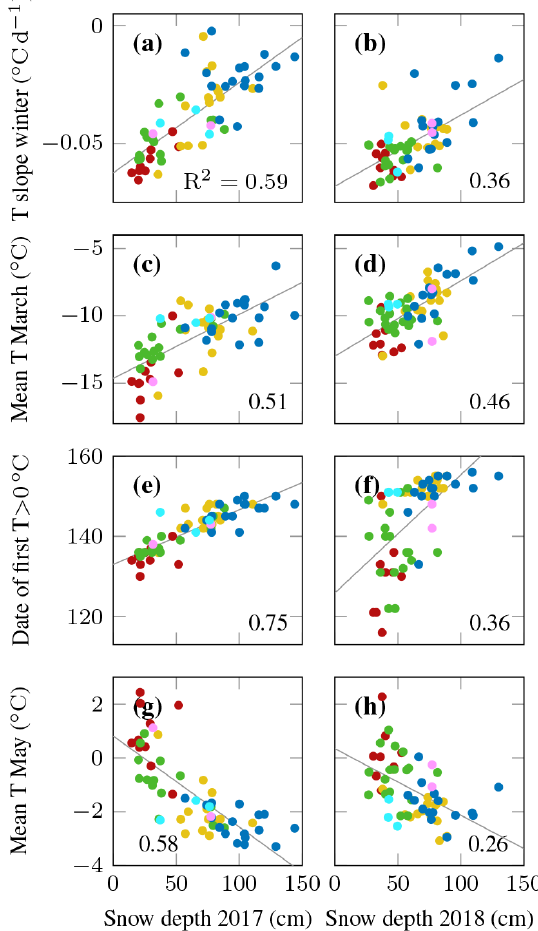
Figure 7. The relationship between snow depth at the end of April 2017 (left column) and 2018 (right column) and (a, b) rate of cool- ing in winter; (c, d) mean temperature in March; (e, f) day of year when the topsoil warms above 0 ◦ C; (g, h) mean temperature in May; the symbol colours refer to different vegetation types (see e.g. Fig. 6); the numbers indicate the Pearson’s correlation coefficient R 2 ; the thin lines are regression lines of significant ( p < 0 . 05) rela- tionships.